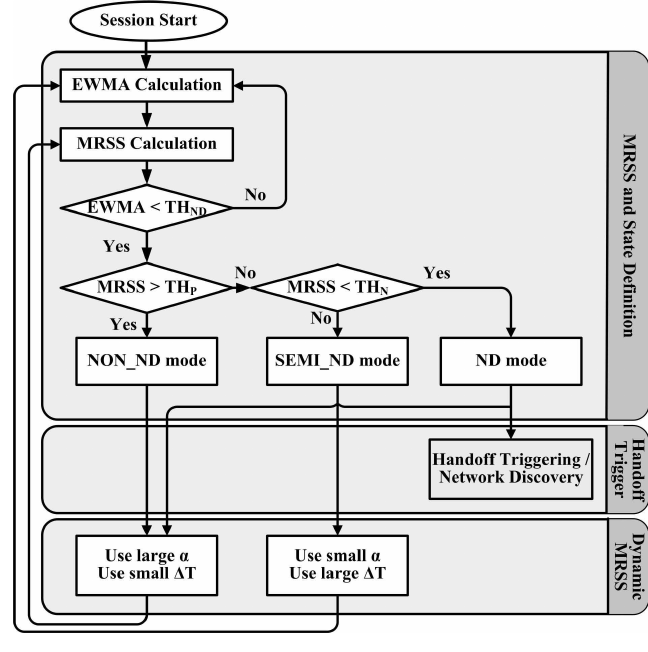
Figure 3. The flow chart of DMRSS-based handoff